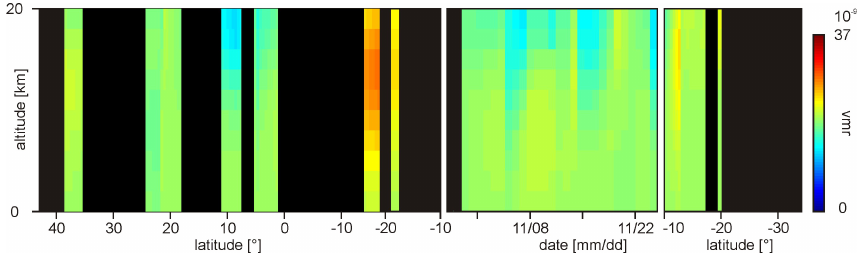
Fig. 8. HCN profiles retrieved from the solar absorption FTIR measurements during the ship campaign with RV Sonne in the Western Pacific showing the influence of biomass burning emissions on Western Pacific